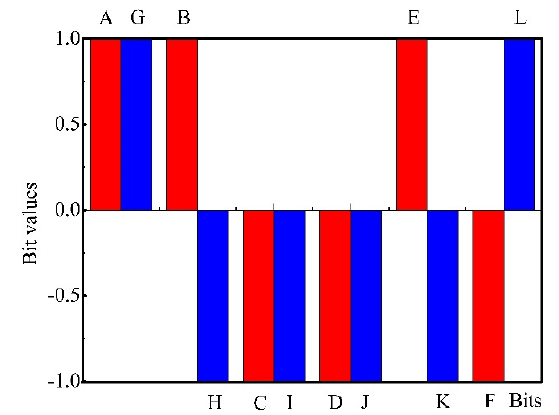
Figure 6. Binary and ternary fingerprints of the bacterium sample. Red: measurement-1; blue: measurement-2 (of the same sample).